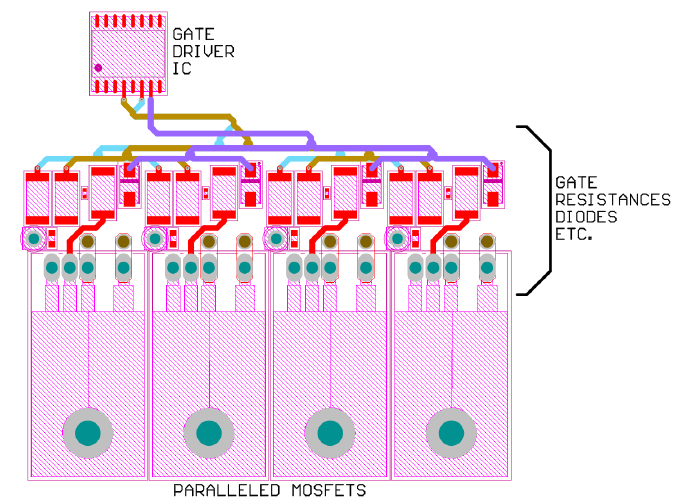
Figure 6. Layout of the Active Miller Clamp protection.